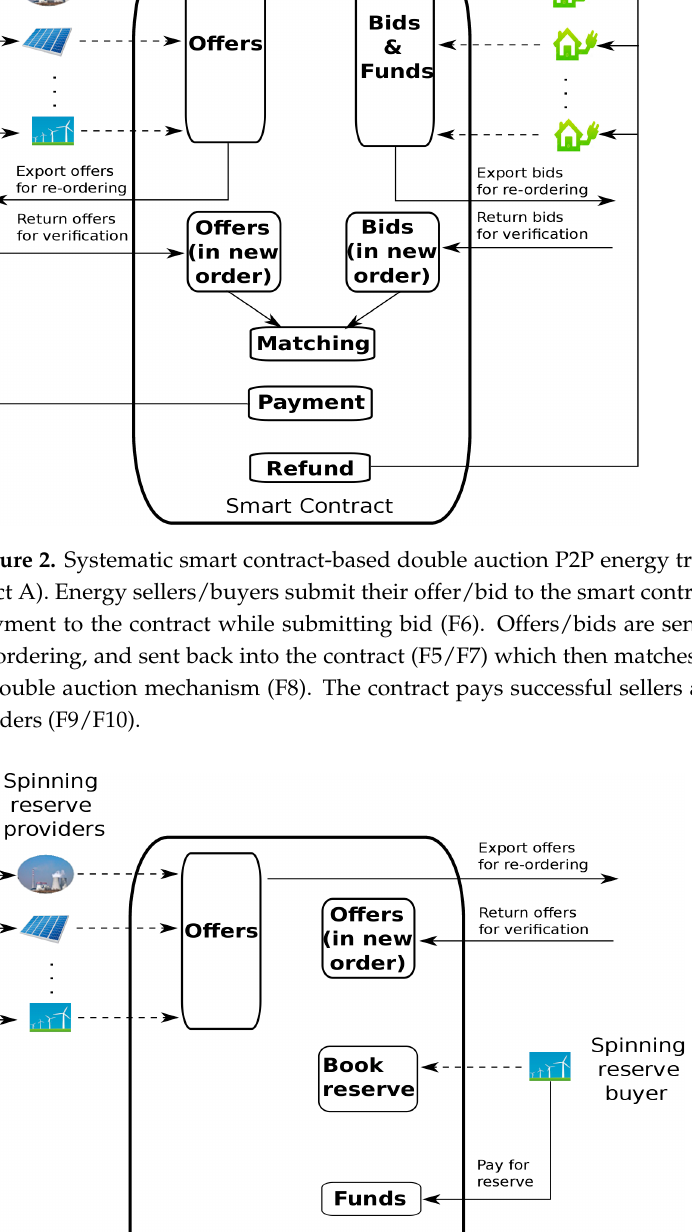
Figure 4. Flowchart of the matching function in the smart contract-enabled energy double auction scheme. The ‘Bidding’ section involves the reception and re-ordering of offers and bids, while